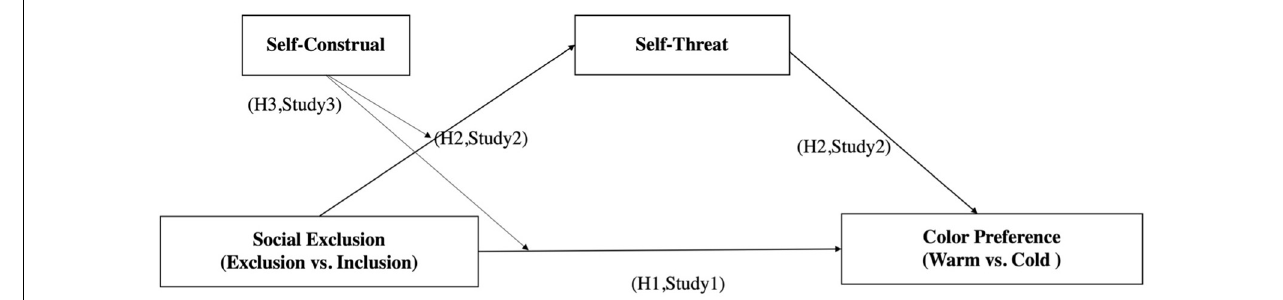
FIGURE 1 | Conceptual